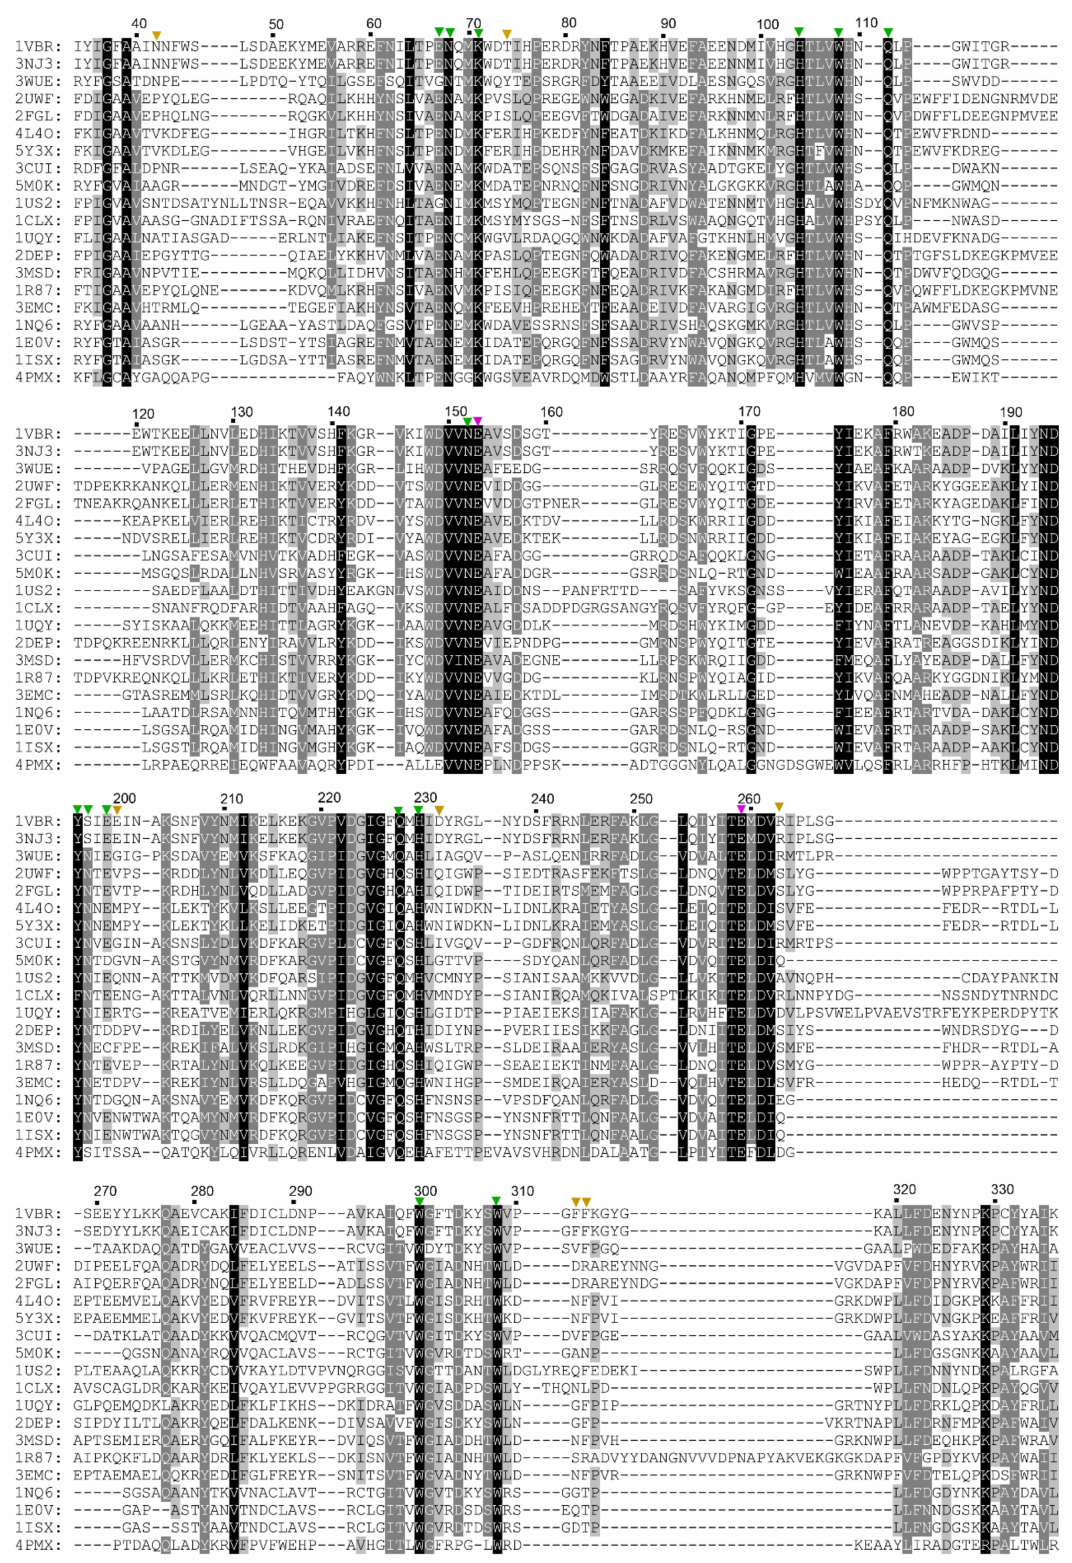
Figure 2. Multiple amino acid sequence alignments of the catalytic domains of TmxB and other structure-determined GH10 xylanases. Conserved amino acids are highlighted in black (strictly)